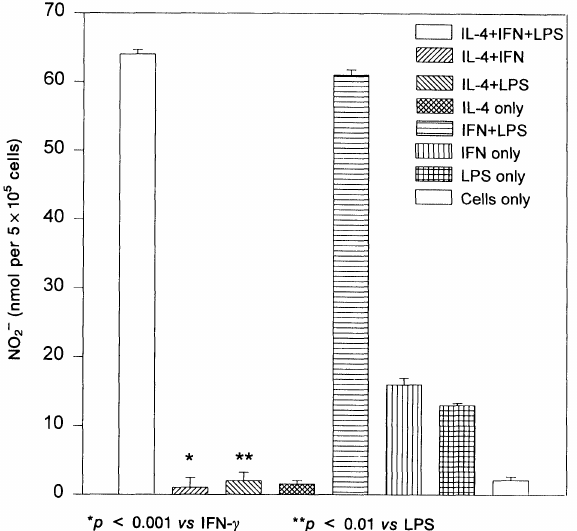
FIG. 1. Effect of IL-4 (100 U/ml) pre-treatment on IFN-T (IFN)- (100 U/ml) or LPS-(100 ng/ml) stimulated nitric oxide produc- tion in RAW 264.7 macrophages. Results shown are mean S.E. for three separate experiments performed in